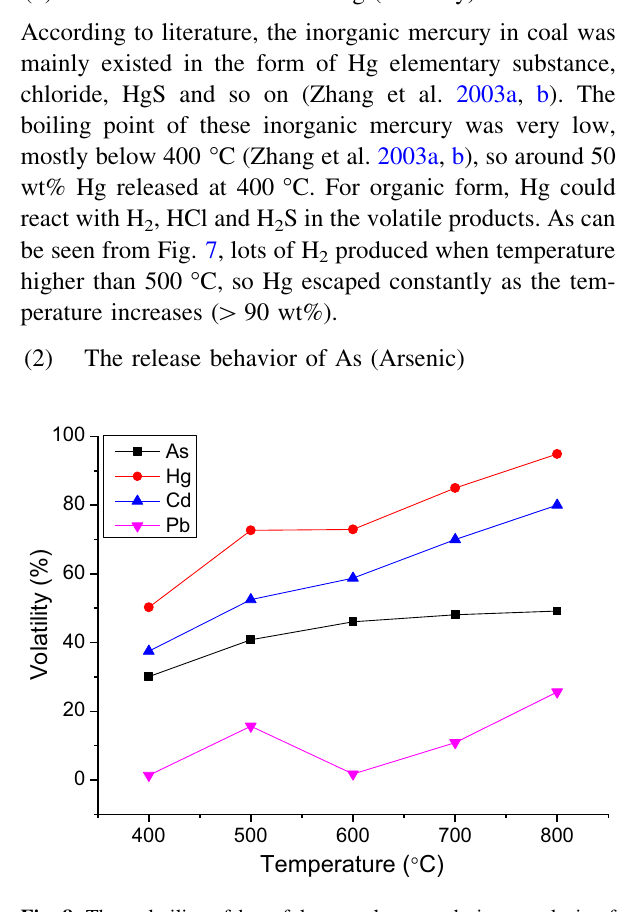
Fig. 8 The volatility of harmful trace elements during pyrolysis of MZH